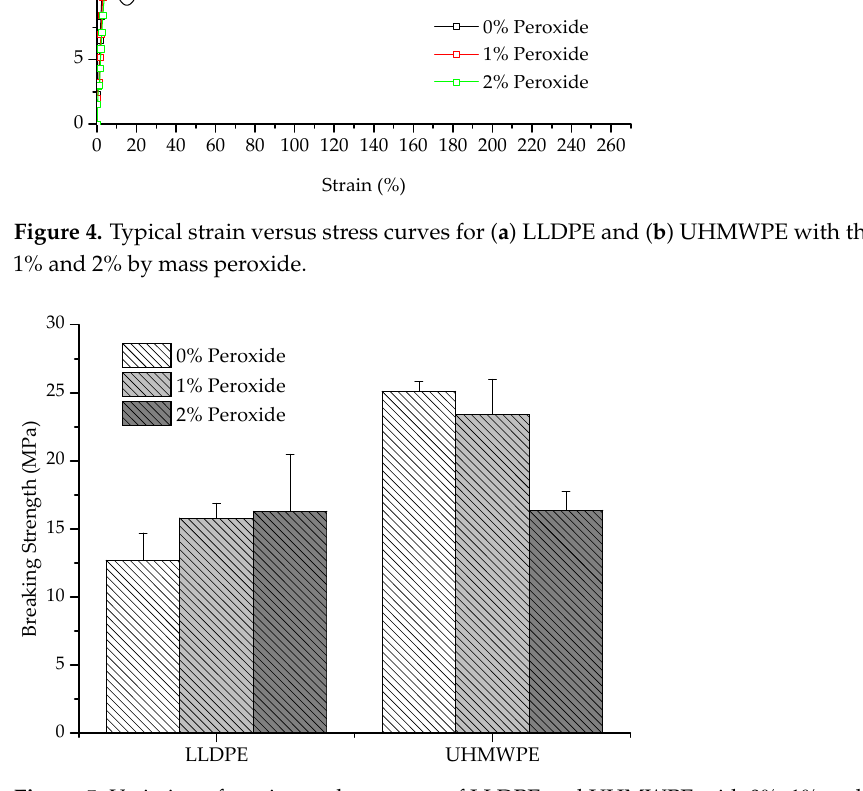
Figure 5. Variation of tension at the rupture of LLDPE and UHMWPE with 0%, 1% and 2% peroxide.